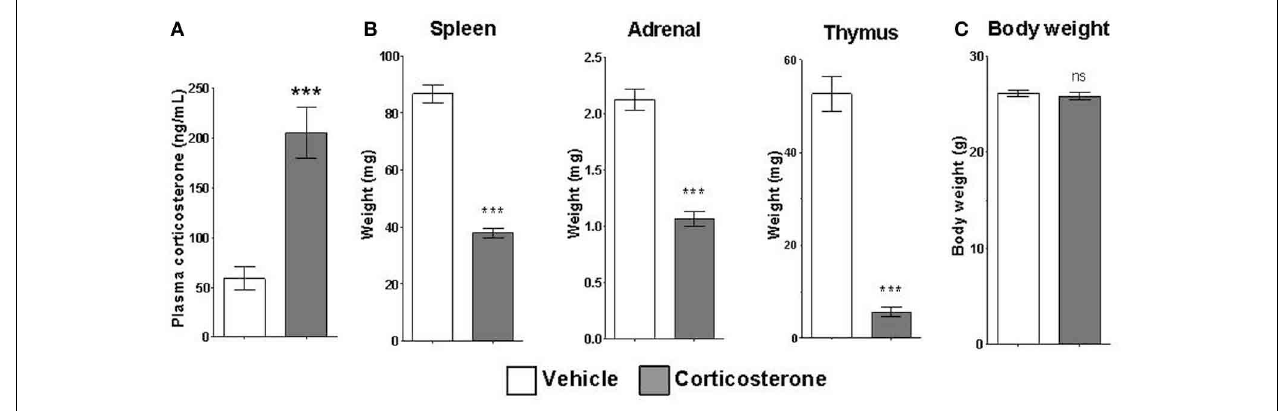
FIGURE 4 | Chronic corticosterone administration via drinking water results in acute and chronic corticosterone elevations. (A) Plasma corticosterone levels after 2 weeks access to drinking water containing 10mg/mL corticosterone vs. vehicle. (B) Weights of